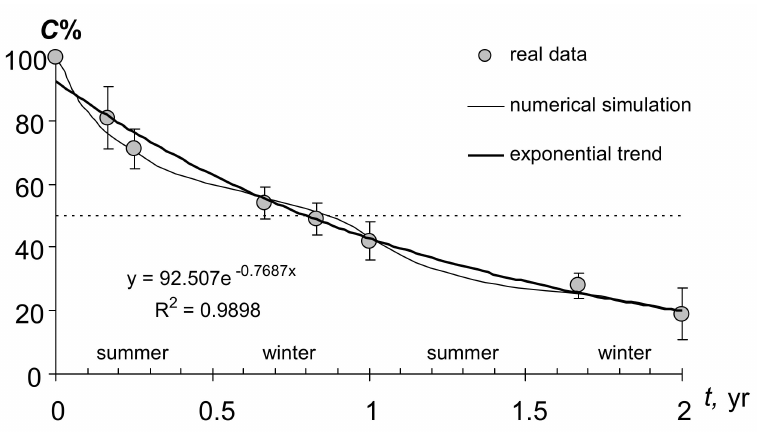
Figure 2. Biodegradation of peat (2-year experiment) on the surface of urban soil in the Moscow